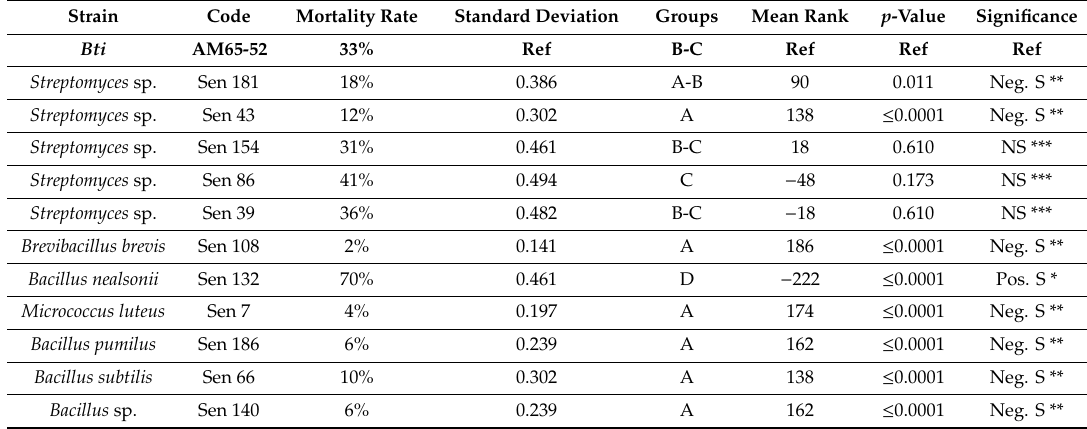
Table 3. Comparison of the e ffi cacy of the strains to that of the positive control Bti . Strain Code Mortality Rate Standard Deviation Groups Mean Rank p -Value Significance Bti AM65-52 33% Ref B-C Ref Ref